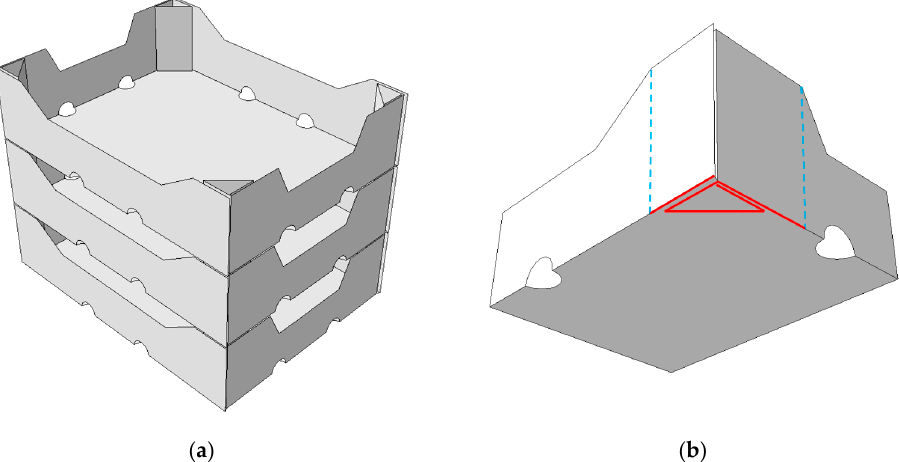
Figure 2. Support schemes of open-top cartons: ( a ) stacking during transport or storage, and ( b ) bottom support sections.